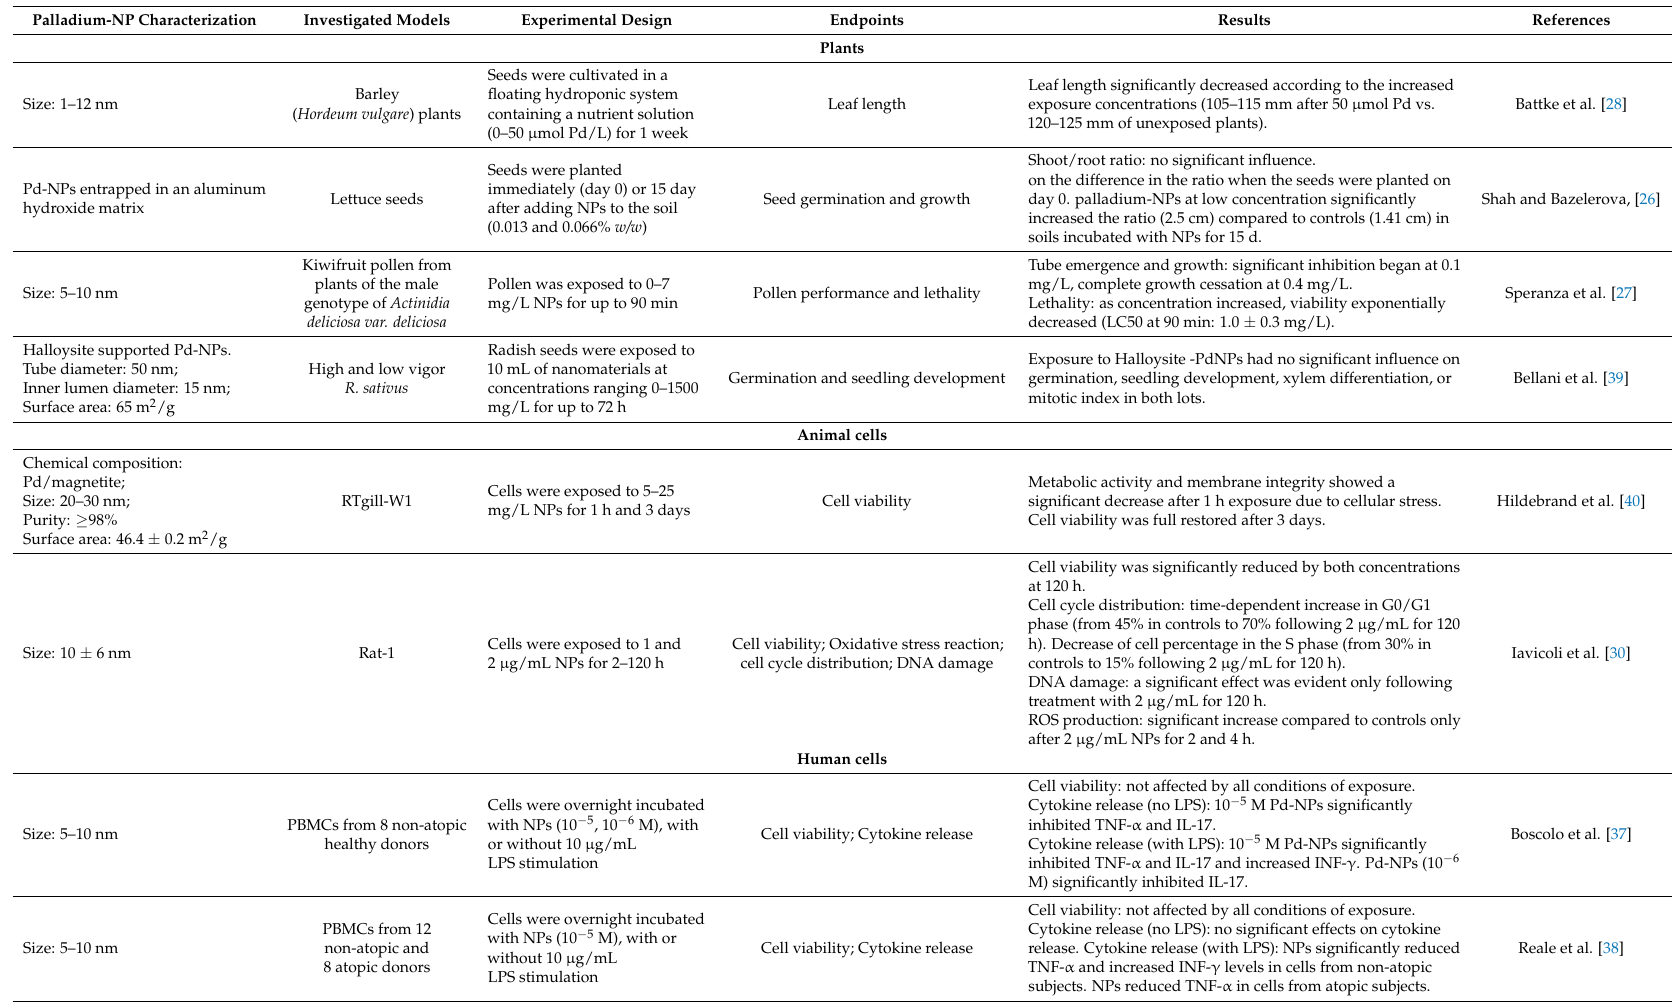
Table 1. Studies investigating the effects of Pd-NPs on in vitro